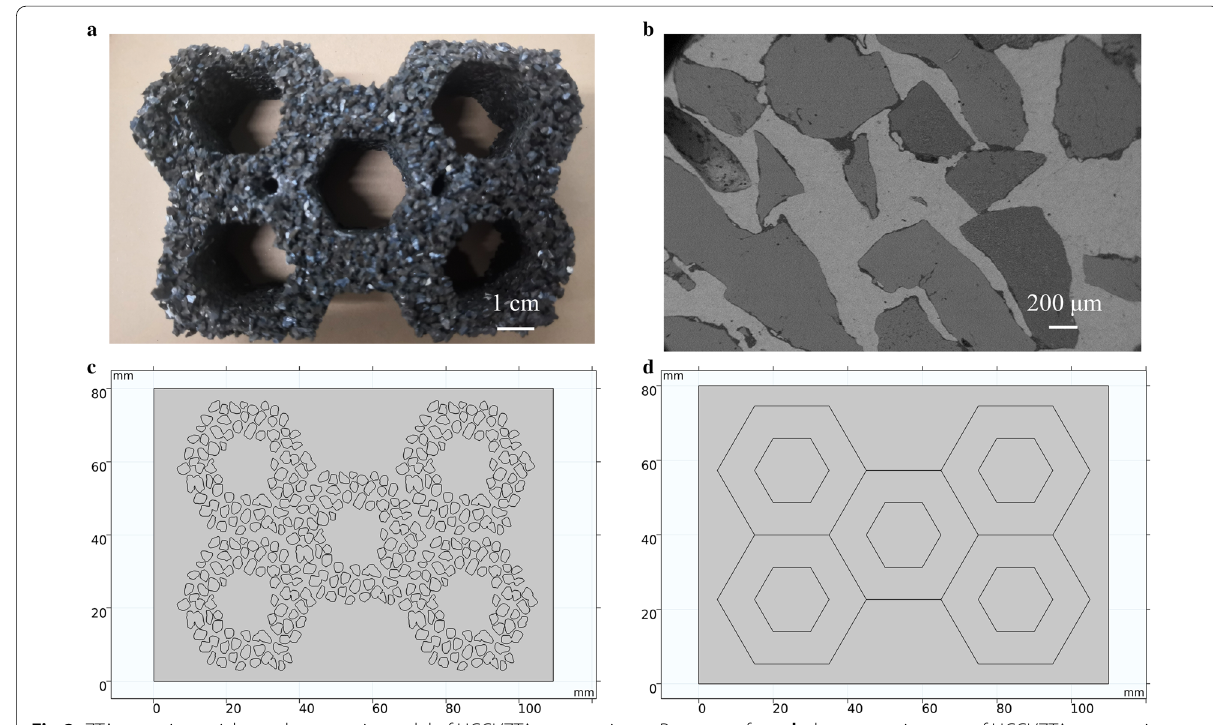
Fig.2 ZTA ceramic particles and geometric model of HCCI/ZTA P composites. a Porous perform, b the composite zone of HCCI/ZTA P composites, c optimized geometric model based on actual particles, d initial geometric model